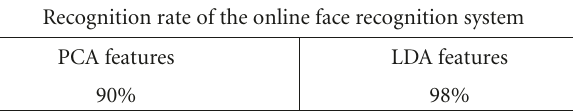
Table 1: Recognition rate of the online face recognition